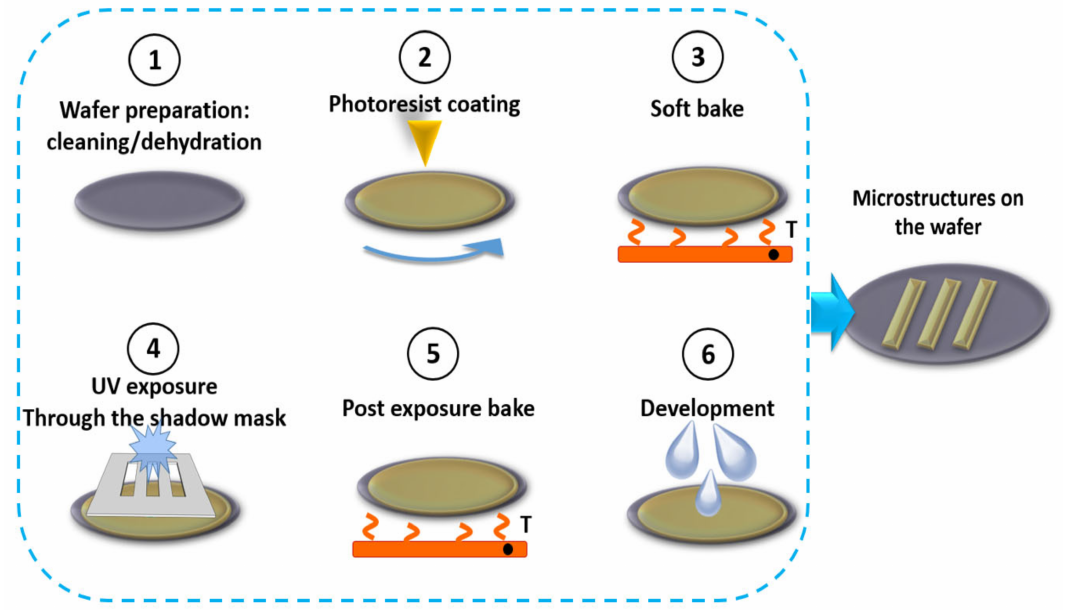
Figure 1. Schematic view on soft lithography process and description of the technological steps, which are wafer preparation, photoresist coating, soft bake, UV exposure through the shadow mask, post exposure bake and